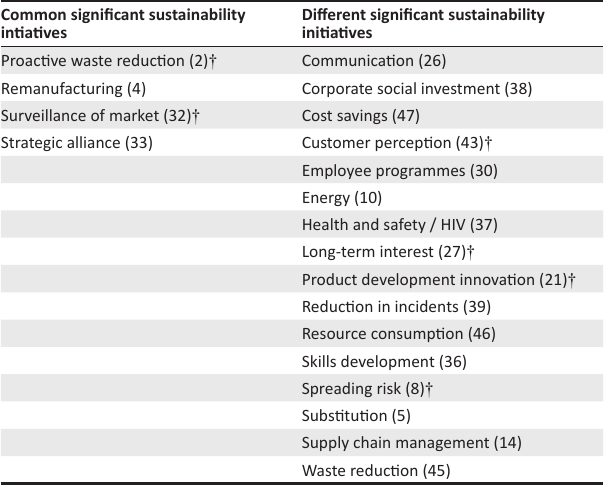
relationship. If the relationship is nonlinear, then one or both TABLE 7: Significant sustainability initiatives of the South African listed companies. Common significant sustainability Different significant sustainability intiatives